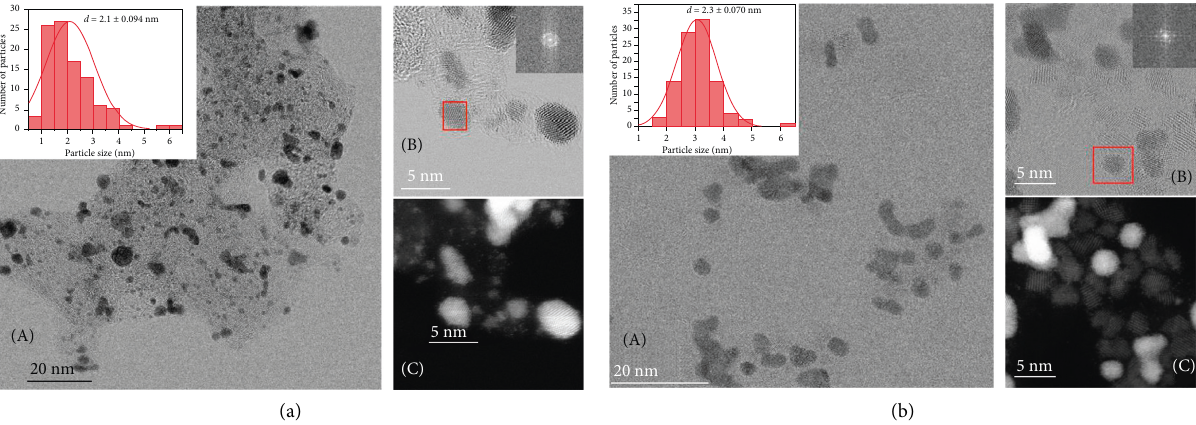
Figure 2: HRTEM micrographs of Sn@Pt/C and Sn@Pt/NG.